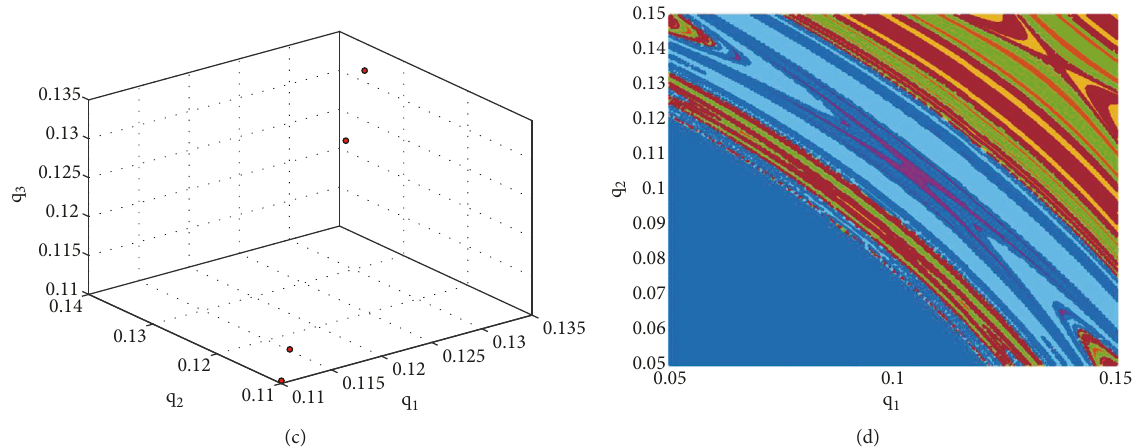
Figure 8: (a) Phase portrait of the period 2-cycle of system (20) at (𝑎,𝑐,𝑘,𝛼,𝑞 0,1 ,𝑞 0,2 , 𝑞 0,3 ,𝑞 4 ) = (0.7, 0.11, 15, 0.19, 0.15, 0.13, 0.11) . (b) The basin of attraction of the period 4-cycle (𝑎,𝑐,𝑘,𝛼,𝑞 3 , 𝑞 4 ) = (0.7, 0.11, 17.85, 0.5, 0.13, 0.11) . (c) Phase portrait of the period 4-cycle of system (20) at (𝑎,𝑐,𝑘,𝛼,𝑞 0,1 , 𝑞 0,2 ,𝑞 0,3 ,𝑞 4 ) = (0.7,0.11, 17.85, 0.19, 0.15, 0.13, 0.11) . (d) The basin of attraction of the period 8-cycle (𝑎, 𝑐, 𝑘, 𝛼, 𝑞 3 ,𝑞 4 ) = (0.7, 0.11, 18.62, 0.5, 0.13, 0.11) .